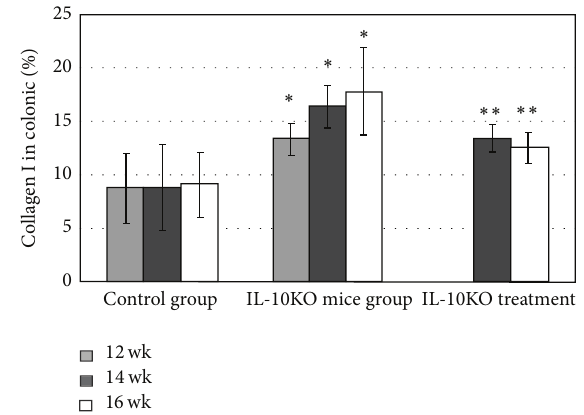
Figure 4: Trichrome image analysis: collagen I in colonic (%) ∗ 𝑃 < 0.05 , versus control group; ∗∗ 𝑃 < 0.05 , versus IL-10KO mice